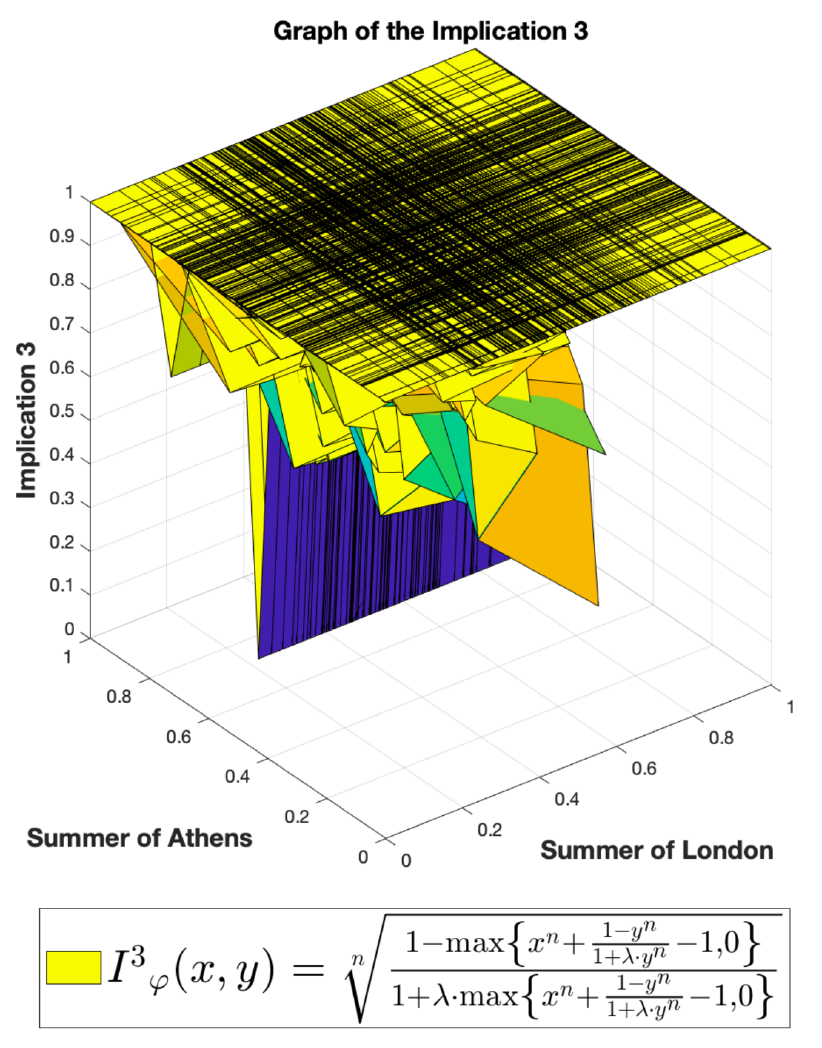
Figure 3. Graph of the Implication